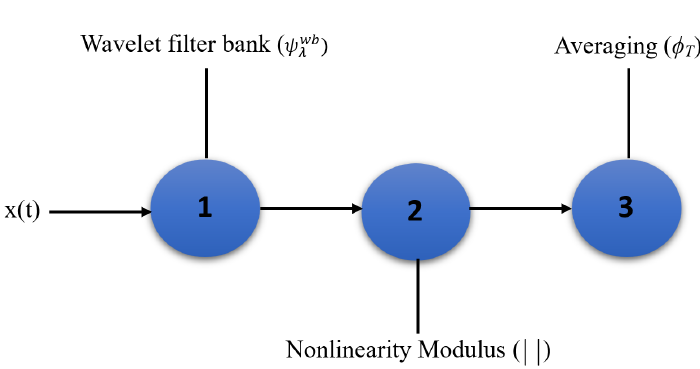
Figure 1. Main steps of WST, where x ( t ) is the input signal, ψ wb frequency, and φ T is the averaging in window with width T .